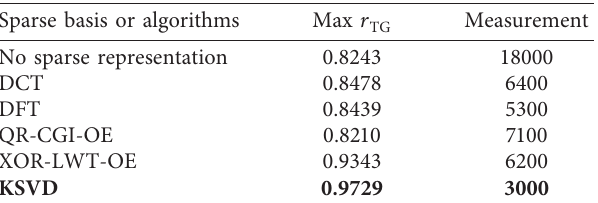
Table 4: The best reconstructed r and measurement of different TG sparse basis and other